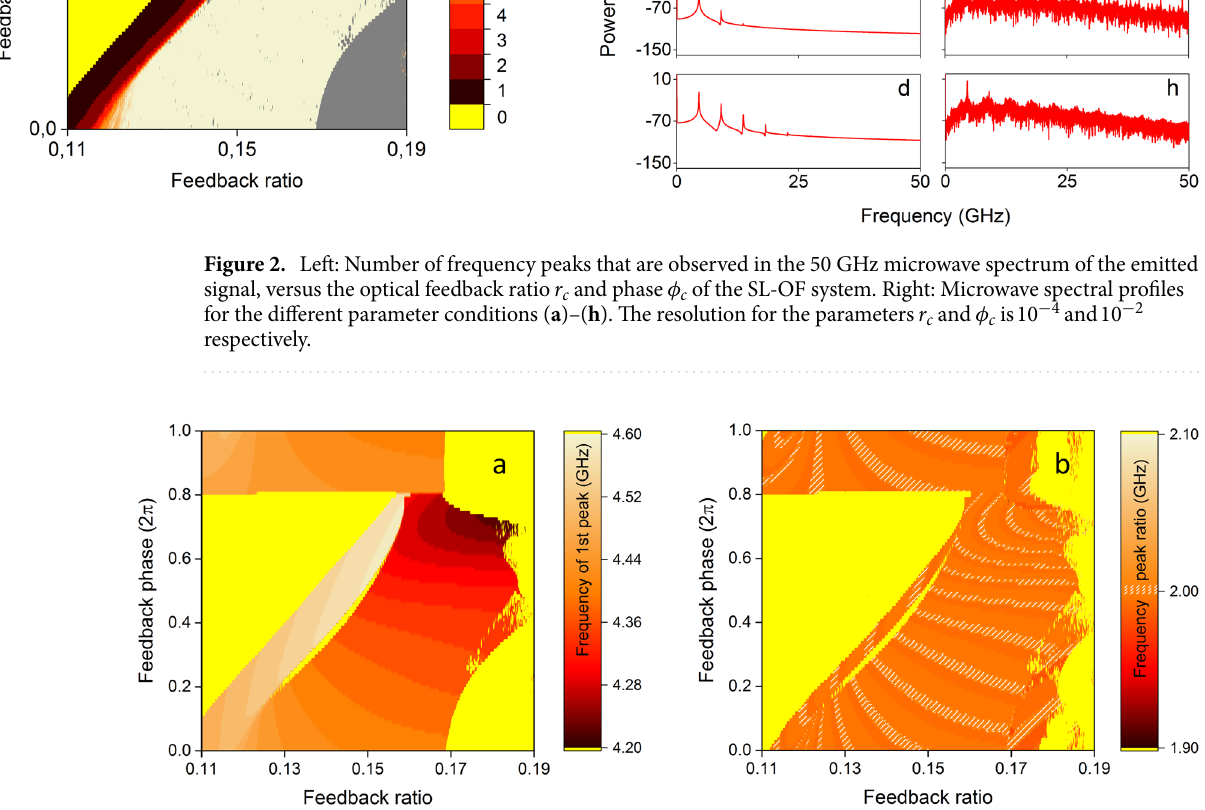
Figure 3. ( a ) Microwave frequency of the first tone and ( b ) microwave frequency ratio between the second and the first tone, versus the optical feedback ratio r c and phase φ c of the SL-OF system. The white overlying lines in ( b ) highlight those conditions that satisfy an integer relation equal to 2, with an accuracy of 10 − 4 2 for the parameters r c and φ c is 10 − and 10 −